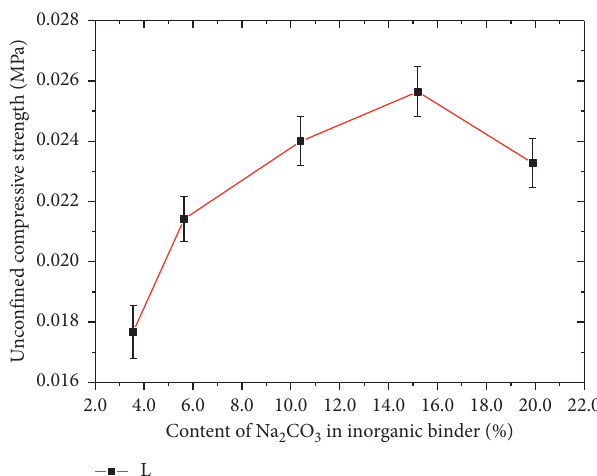
Figure 15: Influence of Na 2 CO 3 content in inorganic binders on UCS of sample during the 90 d curing